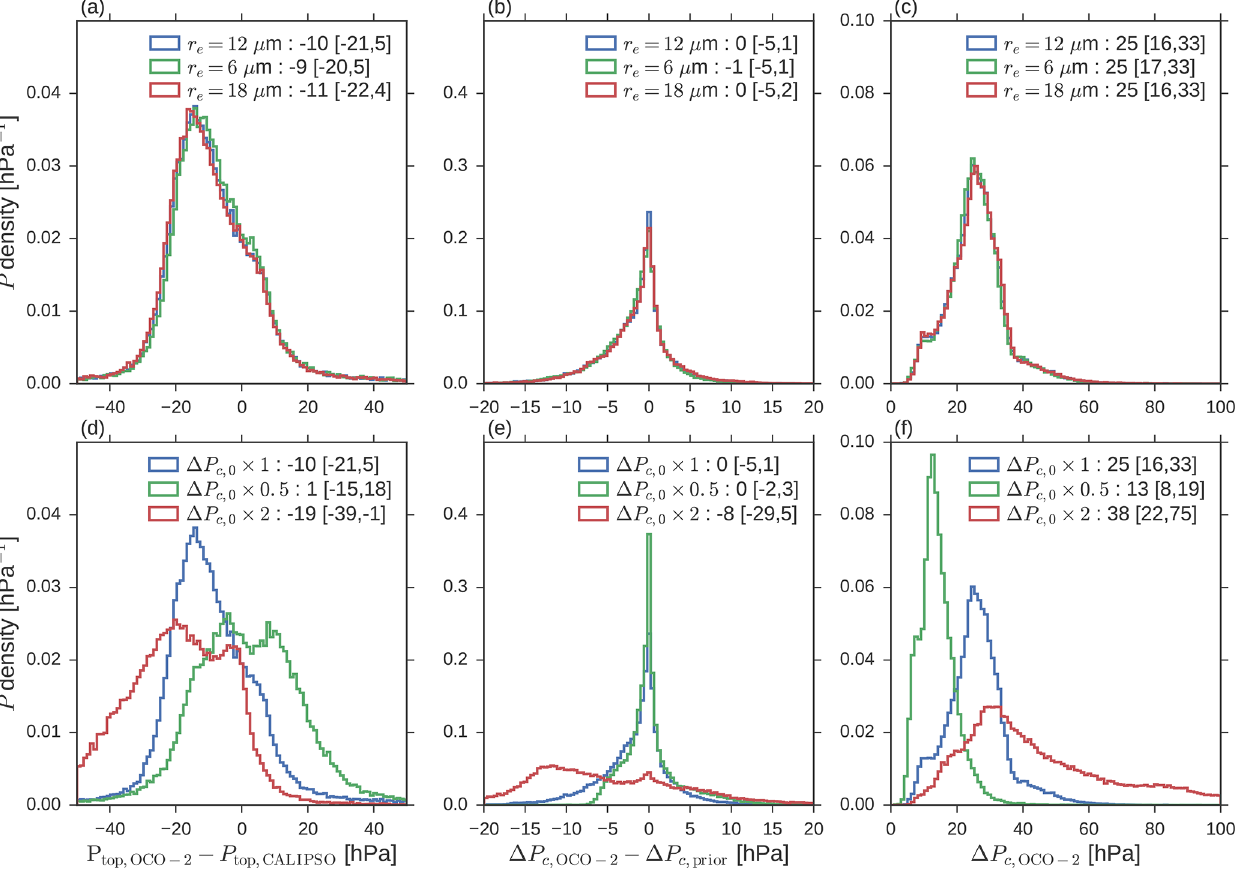
Figure 10. Retrieval properties for 10 orbits when assumed r e , h and prior (cid:49)P c are changed. (a) OCO-2 minus CALIPSO P top difference for default r e , h = 12µm compared with 6 and 18µm, (b) (cid:49)P c difference for changed r e , h , (c) (cid:49)P c retrieved for changed r e , (d) P top difference for default (cid:49)P c prior, and for when this is scaled by 0.5 or 2.0, (e) (cid:49)P c for the same and (f) retrieved (cid:49)P c for the